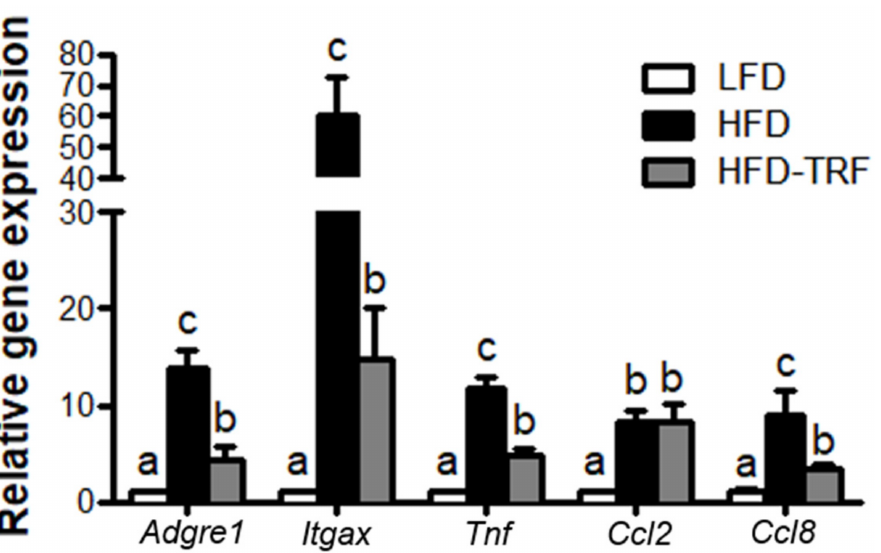
Figure 5. Effects of time-restricted feeding (TRF) on inflammatory mediator gene expressions in AT. Quantitative real-time RT-PCR analysis of selected proinflammatory macrophages (F4/80 and CD11c), cytokine (TNF α ) and chemokines (Ccl2, Ccl8) in epididymal fat after 14 weeks of different feeding regimens. LFD, low-fat diet ad libitum; HFD, high-fat diet ad libitum; HFD-TRF, 8 weeks of time-restricted feeding after 6 weeks of high-fat diet ad libitum. Data are presented as mean ± SEM ( n = 7). a,b,c Different superscripts indicate significant difference at least at p < 0.05 by ANOVA with Tukey’s post hoc